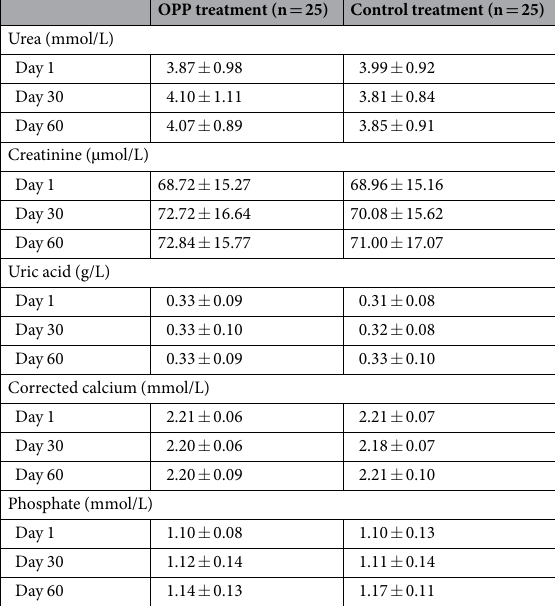
Table 6. Plasma renal function profiles (mean ±